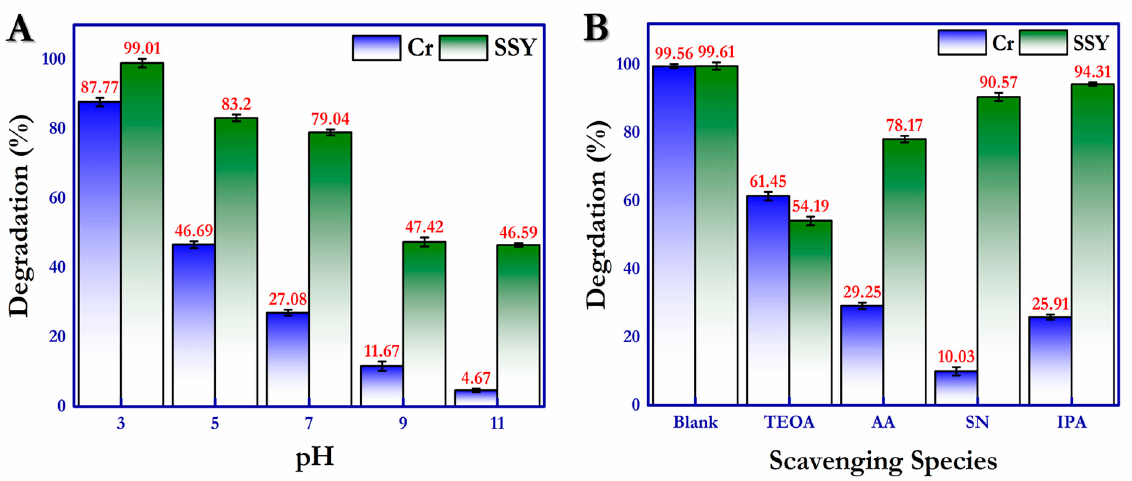
Figure 12. Photoreduction of Cr (VI) and photooxidation of SSY FCF at different pHs ( A ) and in the presence of different scavenging species ( B ) in the presence of the g-C 3 N 4 –SO 3 H photocatalyst under visible light.